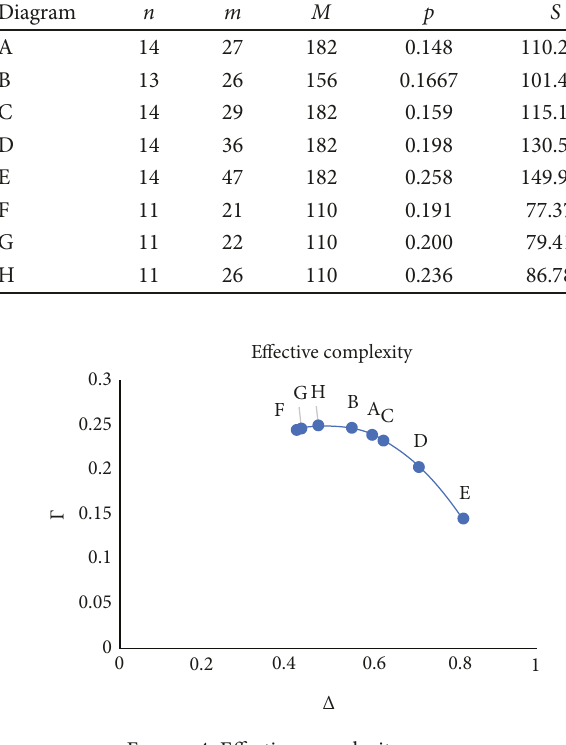
Figure 4: E ff ective complexity